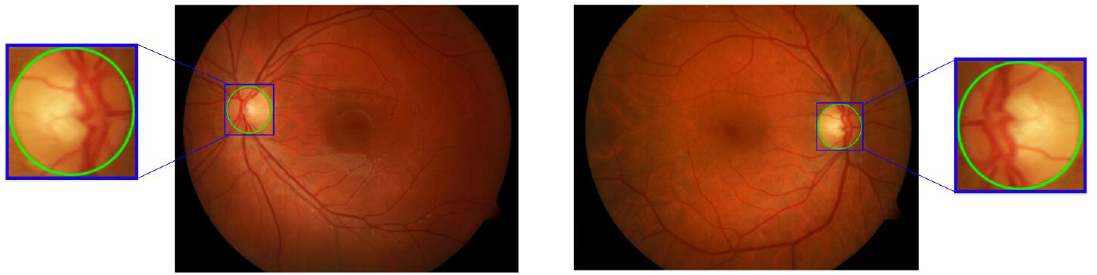
Figure 1. The construction of template image. The blue rectangle is the minimum bounding rectangle containing the whole OD region marked by a green